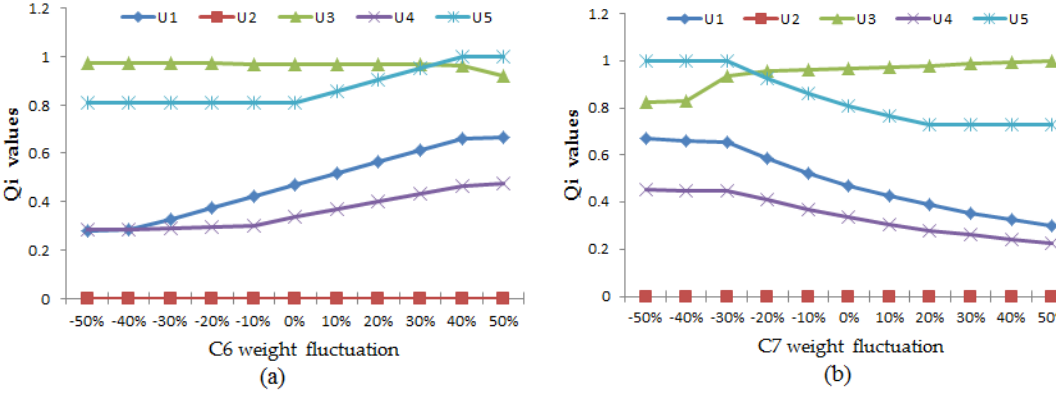
Figure 7. Weight sensitivity analysis for technology level criteria. ( a ) Weight sensitivity analysis for sub-criterion C6. ( b ) Weight sensitivity analysis for sub-criterion C7.